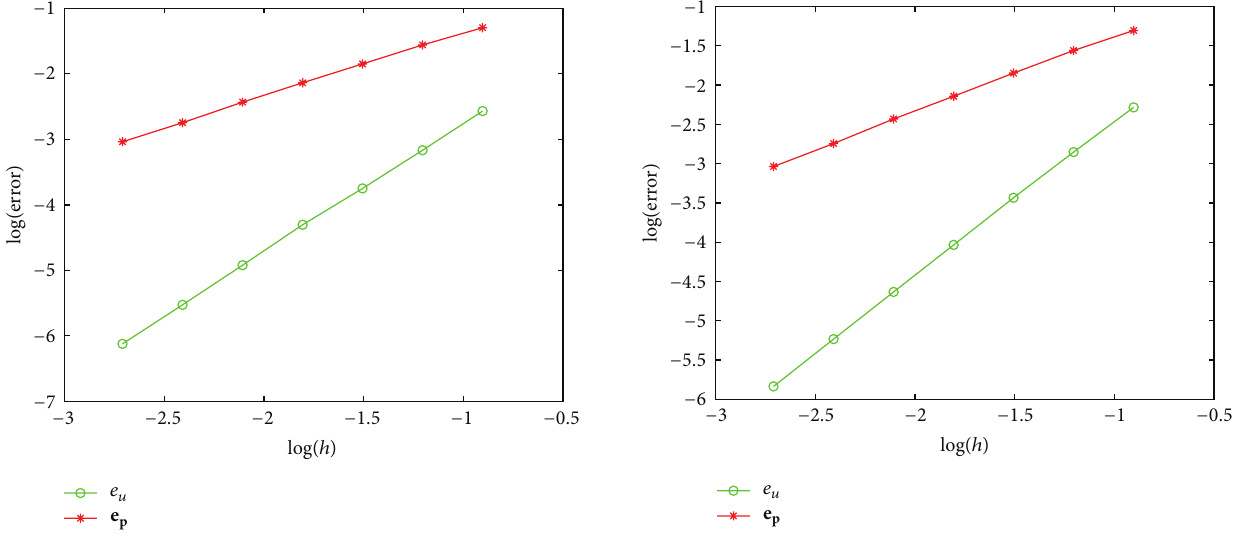
Figure 5: The convergence rates of 𝐿 2 norm in the exact 𝑢 and its flux p for 𝛽 1 : 𝛽 2 = 10: 1.